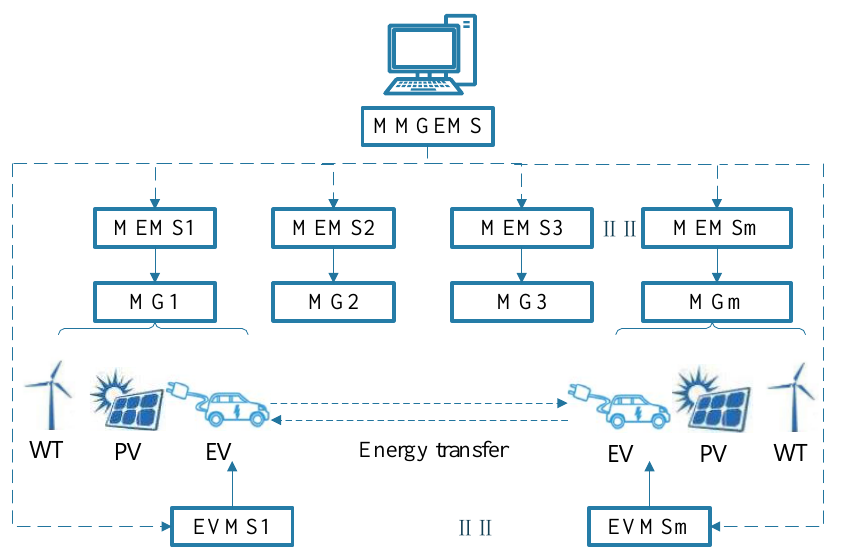
Figure 2. Structure of a DC multi-microgrid control system.